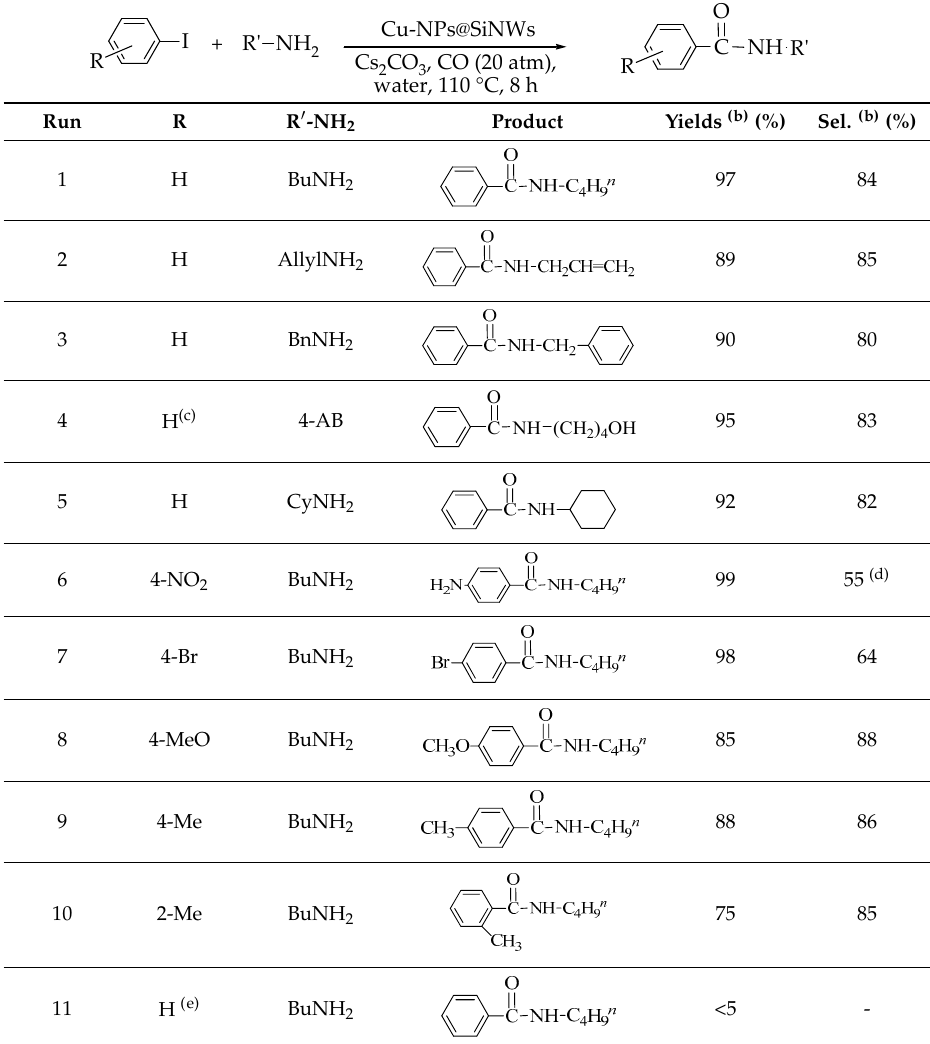
Table 2. Aminocarbonylation of iodoarenes catalyzed by CuNP@SiNWs (a) .